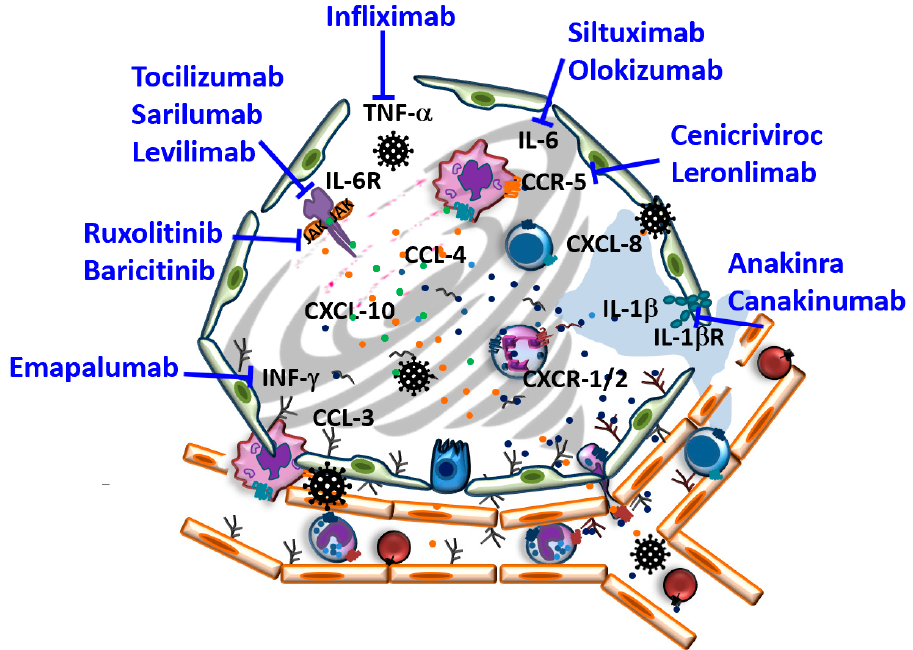
Figure 1. Schematic illustration of severe acute respiratory syndrome coronavirus 2 (SARS-CoV-2) infected alveoli and therapeutically explored targets aiming to interfere with SARS-CoV-2 induced cytokine storm in coronavirus disease (COVID-19) (for further details, see text).